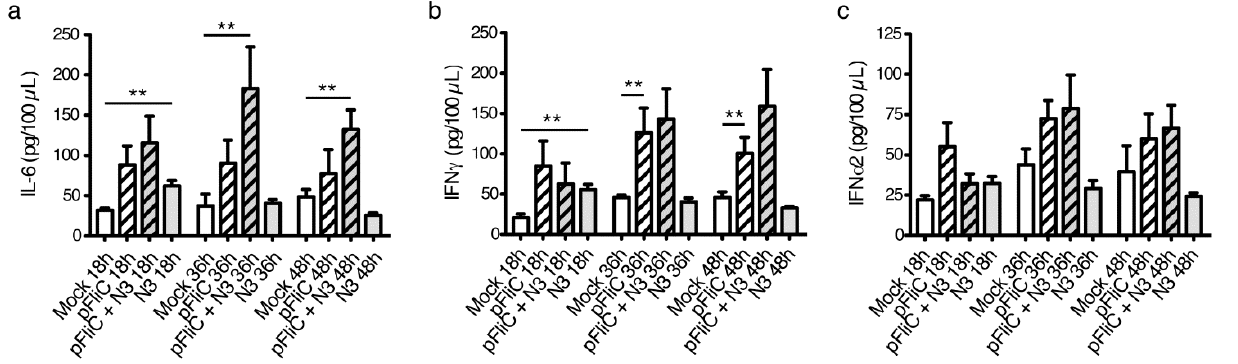
Figure 10. Cytokines produced after intranasal adminstration of adjuvant combinations. Kinetic analysis of ( a ) IL-6, ( b ) IFN  , and IFN  2 ( c ) at 18, 36, and 48 h by ELISA using nasal wash samples. Mock adjuvant shown as White bars, use of pFliC(-gly) as Striped Bars, and N3 as Grey bars ( n = 5 mice/group). Data is expressed as the calculated mean ± SEM. Statistical analyses were conducted using a two-tailed Mann-Whitney test. ** Differences relative compared groups defined as p ≤ 0.005 were considered